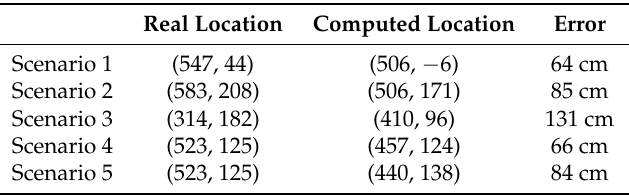
Figure 12. Open and closed-door localisation tests. Person at equal distance from all luminaires. Luminaires are represented using yellow circles with black border, the person’s real position is represented using the green cross shape and the detected position is shown using the red diamond. Table 2. Positioning details, for all analysed